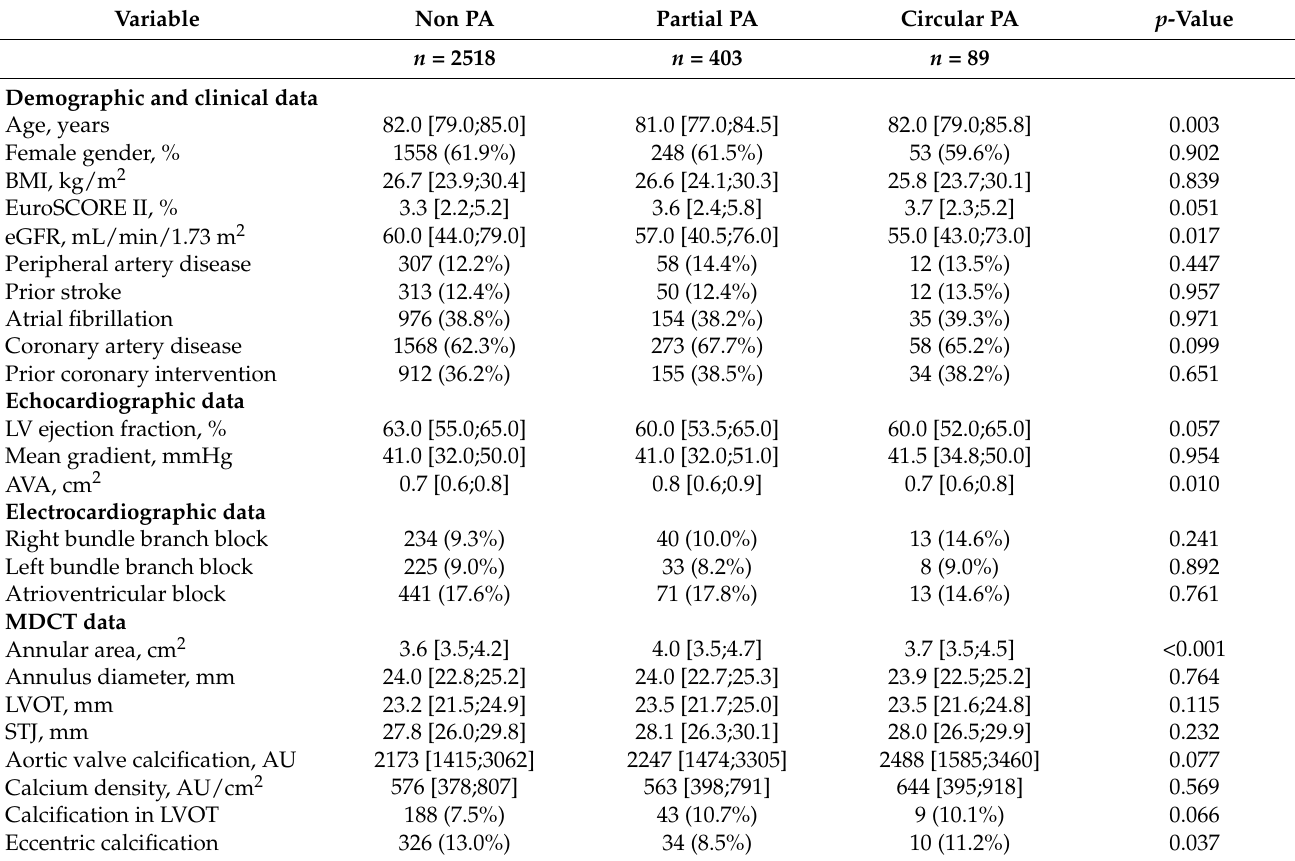
Table 1. Baseline characteristics of the entire